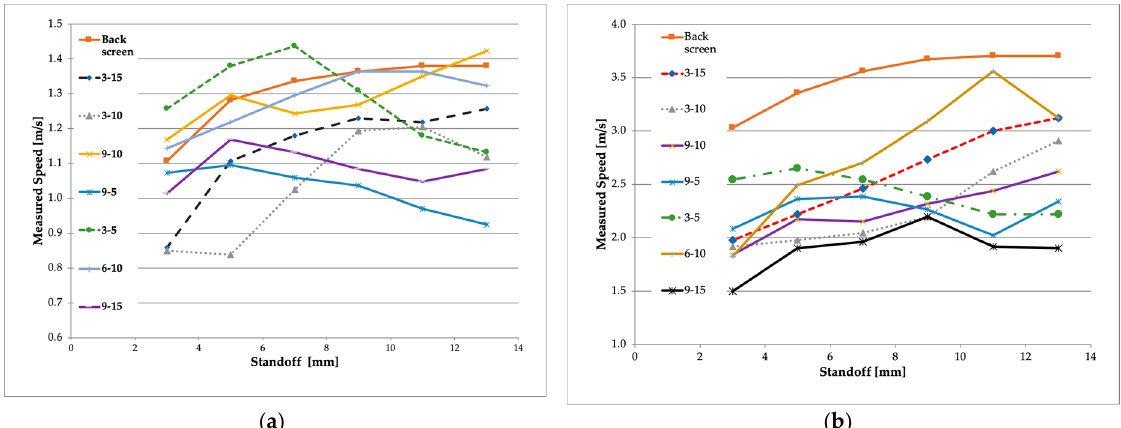
Figure 4. ( a ) Measured flow speed (m/s) as a function of standoff (mm) for all fabric samples tested at a velocity of 3.3 m/s; ( b ) Measured flow speed (m/s) as a function of standoff (mm) for all fabric samples tested at a velocity of 10 m/s. Table 1. Flow ratio summaries averaged across realistic standoff distances of 3, 5 or 7 mm. Wind Speed Hole